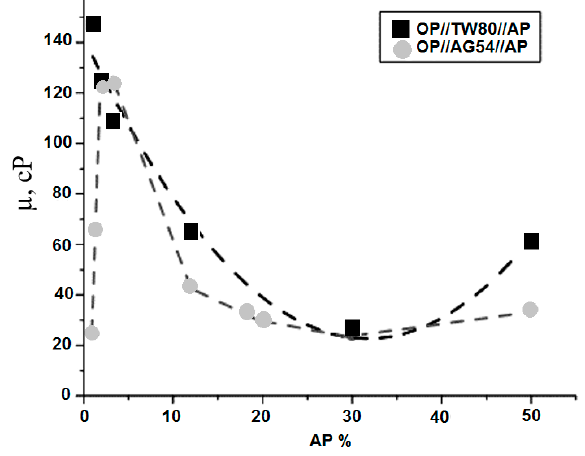
Figure 5. Viscosity of ME as a function of AP % in the OP//TW80//AP and OP//AG54//AP systems at T = 25 °C.